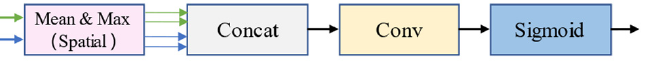
Figure 8. Spatial Attention Module.